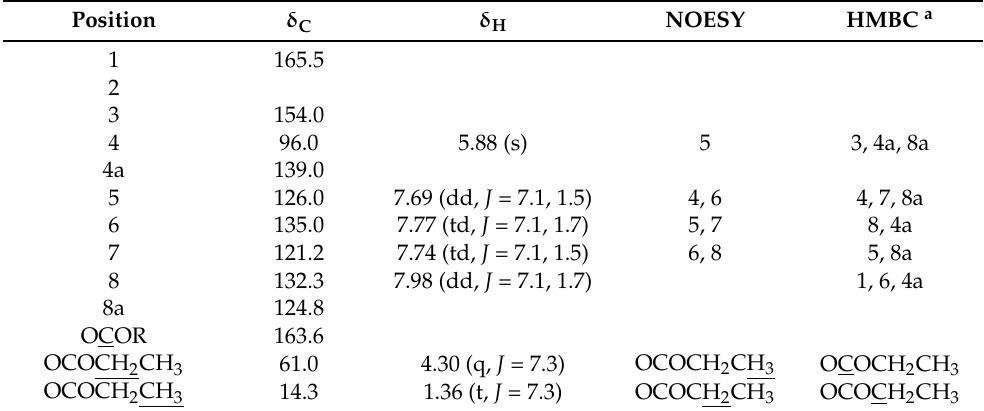
Table 3. NMR data (CDCl 3 ) of 3 . δ in ppm, J in Hz.